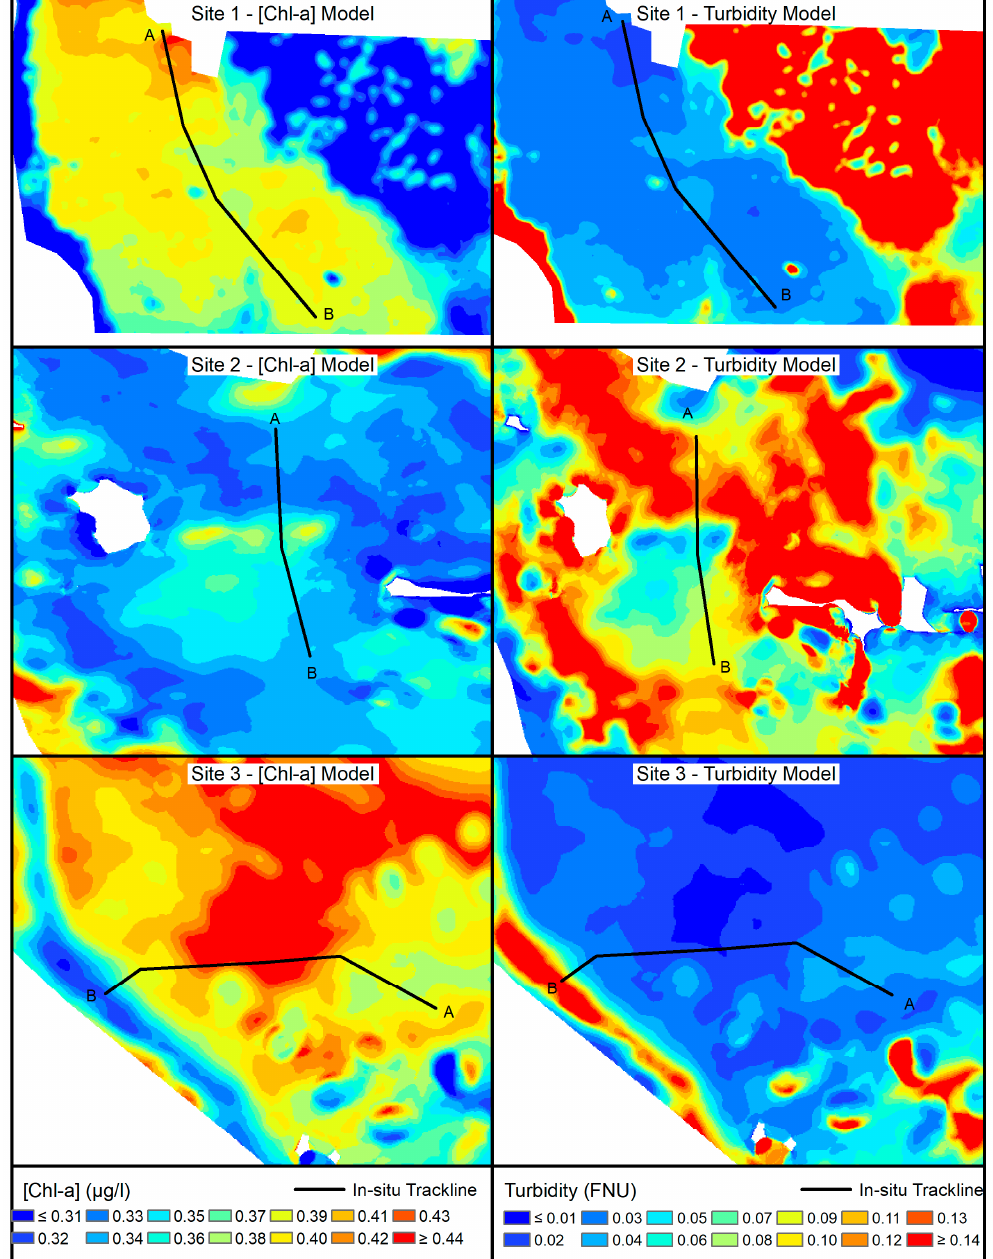
Figure 5. Spatial distribution of the chlorophyll a concentration [Chl-a] ( left column ) and turbidity ( right column ) calculated from the multispectral imagery collected from the UAV at the validation sites in France, using inversed calibration function parameterized for UK sites: [Chl-a] was calculated using the 2-parameter index equation (Equation (10)) and turbidity was calculated using the 3-parameter index equation (Equation (12)). The solid black lines show the track of the in-situ measurements collected with the EXO-1 sensor towed by a boat, beginning at A and finishing at B.